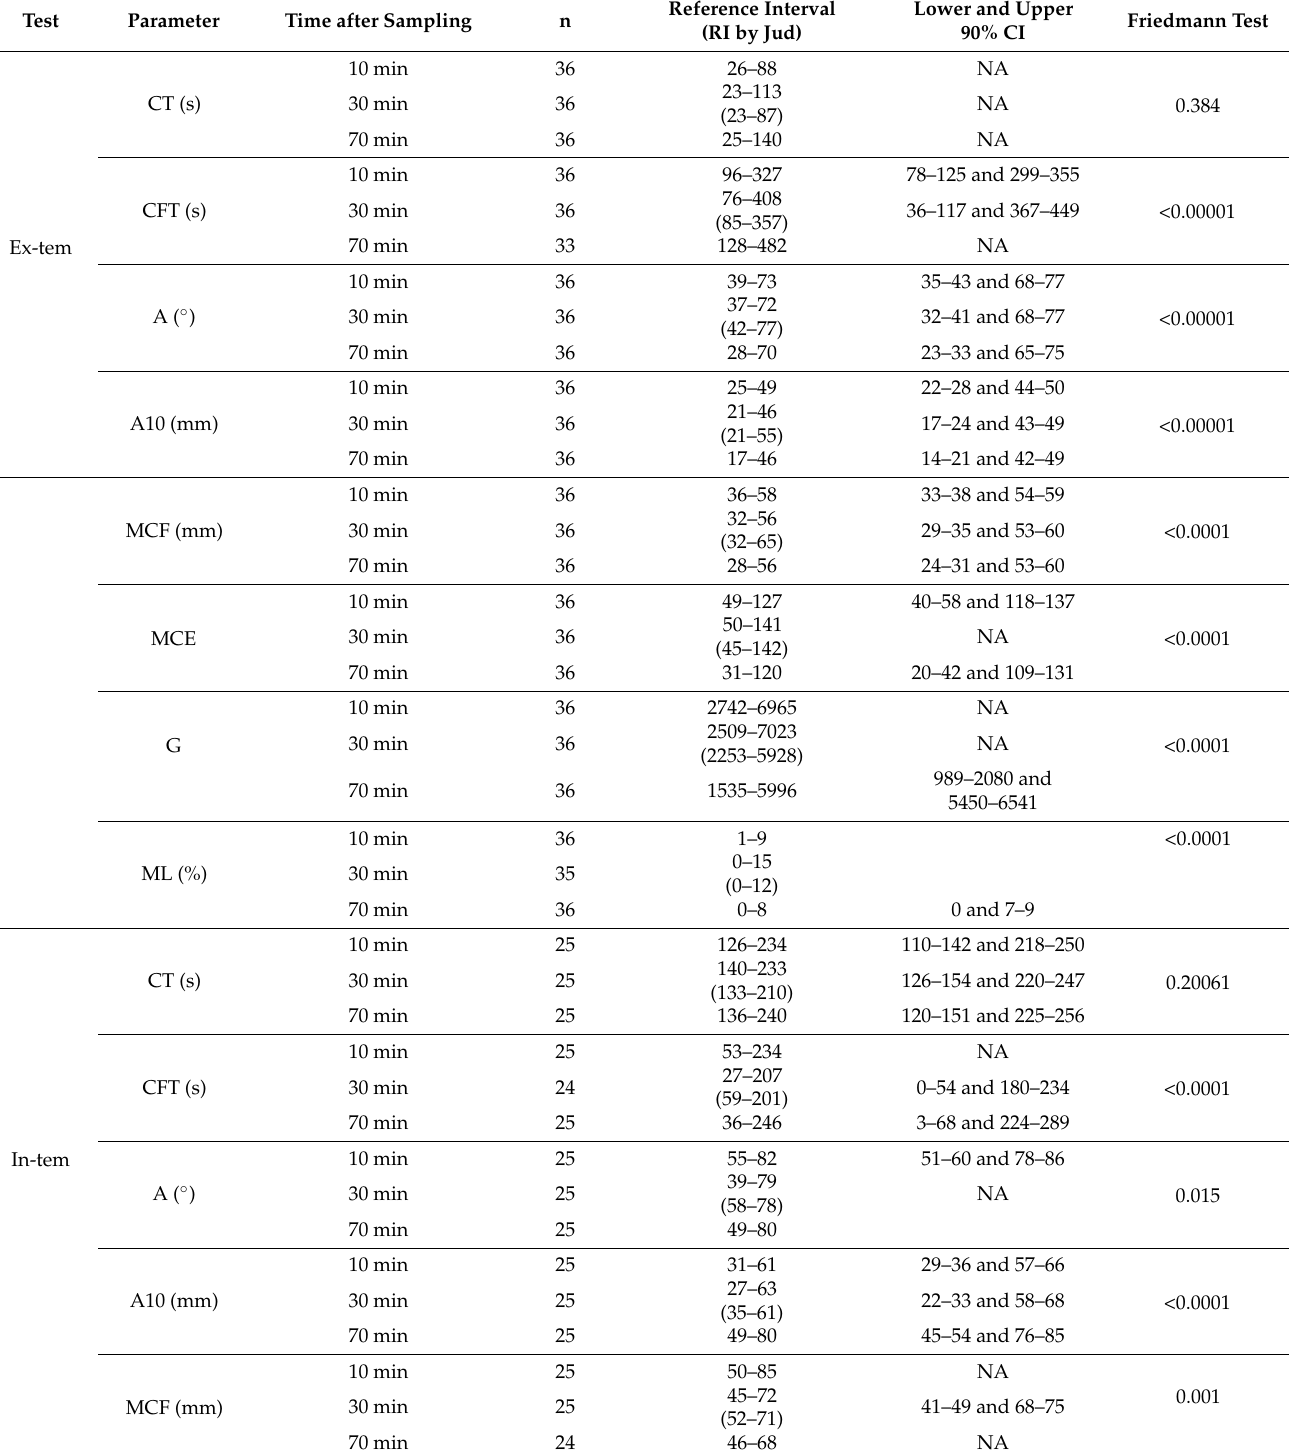
Table 6. Reference intervals for selected parameters of Ex-TEM S, In-TEM S, and Fib-TEM S 10, 30, and 70 min after blood